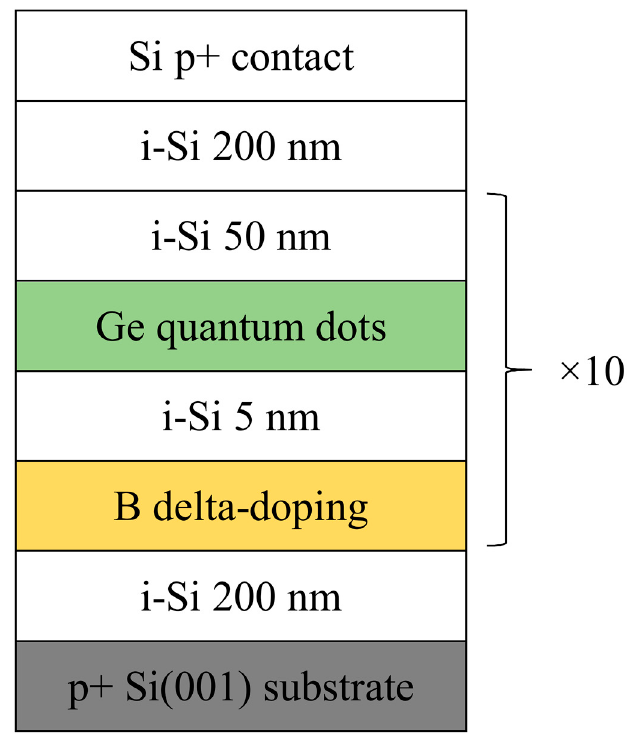
Figure 8. Schematic drawing of the Ge/Si photodetector with 10 layers of quantum dots. Ten layers of germanium quantum dots separated by 50 nm silicon barriers served as active layers. Each Si barrier contained a boron delta-doping layer inserted 5 nm below the Ge-wetting layer. The active region was sandwiched between the 200-nm-thick intrinsic Si buffer and the cap layers. Finally, a 200-nm-thick p + − Si top contact layer was deposited. The noise current, detectivity, and responsivity as a function of voltage and temperature were considered and the study has shown that such a device exhibited low dark current and operated until 200 K